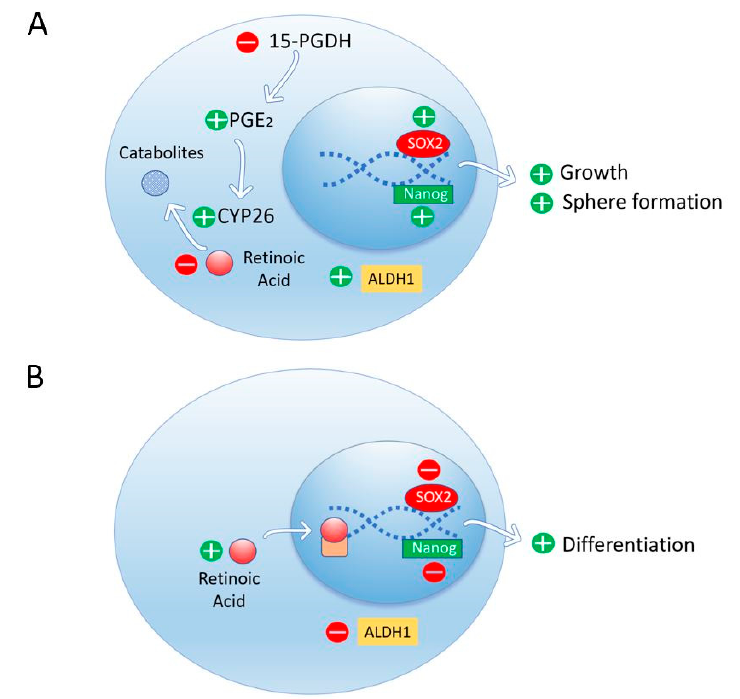
Figure 3. Depletion of RA by an increase of CYP26 expression due to an accumulation of prostaglandin E2 (PGE2) results in high levels of ALDH1, Sox2, and Nanog in tumor cells with growth and sphere formation ( A ). Retinoic acid replacement suppresses ALDH1 signaling in pancreatic ductal adenocarcinoma and induces cell differentiation ( B